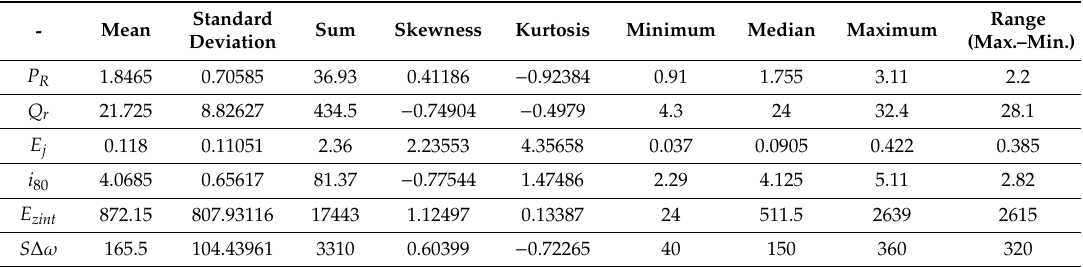
Table A4. Results of the descriptive statistical analysis of variables for the process of corn grinding.